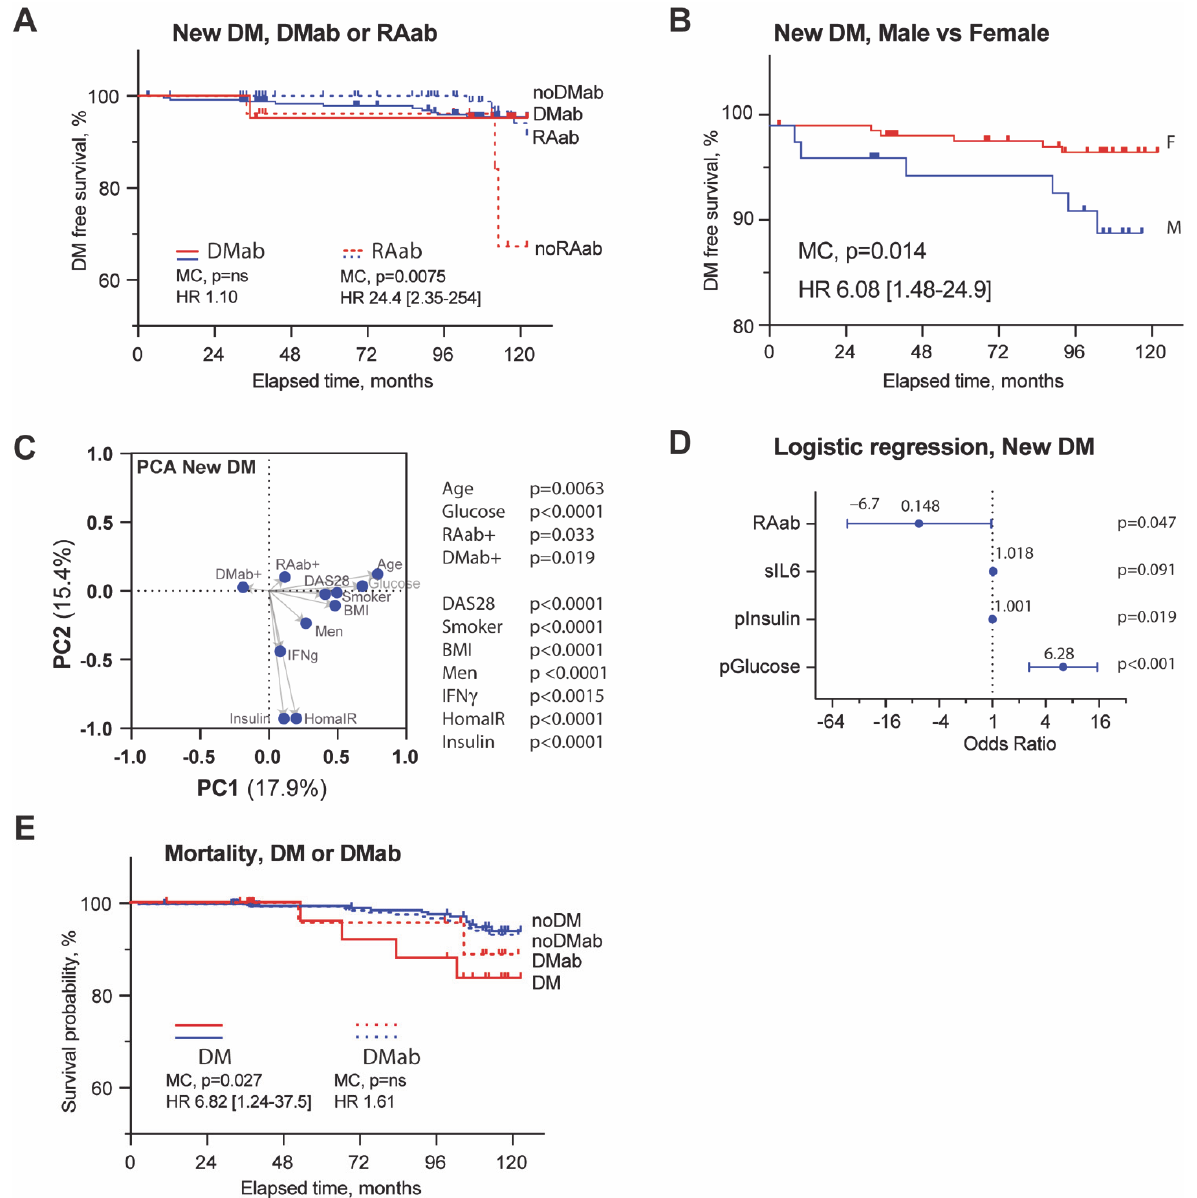
Figure 3. Predictive value of DM-specific antibodies for new cases of DM and mortality in RA patients. ( A ) The Kaplan–Meier curves show the development of new cases of DM in DMab+ ( n = 27 red line) and DMab-negative ( n = 257, blue line) patients and in RAab+ ( n = 234, dash red line) and RAab-negative ( n = 31, dash blue line) patients during the follow-up period of 120 months. The hazard ratio (HR) between the groups was calculated by the Mantel–Cox (MC) regression analysis. ( B ) The Kaplan–Meier curves show the development of new cases of DM in male ( n = 66, red line) and female ( n = 205, blue line) patients. The hazard ratio (HR) between the groups was calculated by the Mantel–Cox regression analysis. ( C ) Scatter plot of principal component analysis (PCA) shows variables associated with new DM cases. Significantly associated variables are indicated with p -value (calculated with least-squares regression). ( D ) Forest plot of variables in the final step of the binary logistic regression analysis predicting new DM cases. p -values were calculated with Wald statistics. ( E ) The Kaplan–Meier curves show mortality in RA patients with DM ( n = 30, red line) and without DM ( n = 254, blue line) and in DMab+ ( n = 27, dash red line) and DMab-negative ( n = 257, dash blue line) patients during the follow-up period of 120 months. The hazard ratio (HR) between the groups was calculated by the Mantel–Cox regression